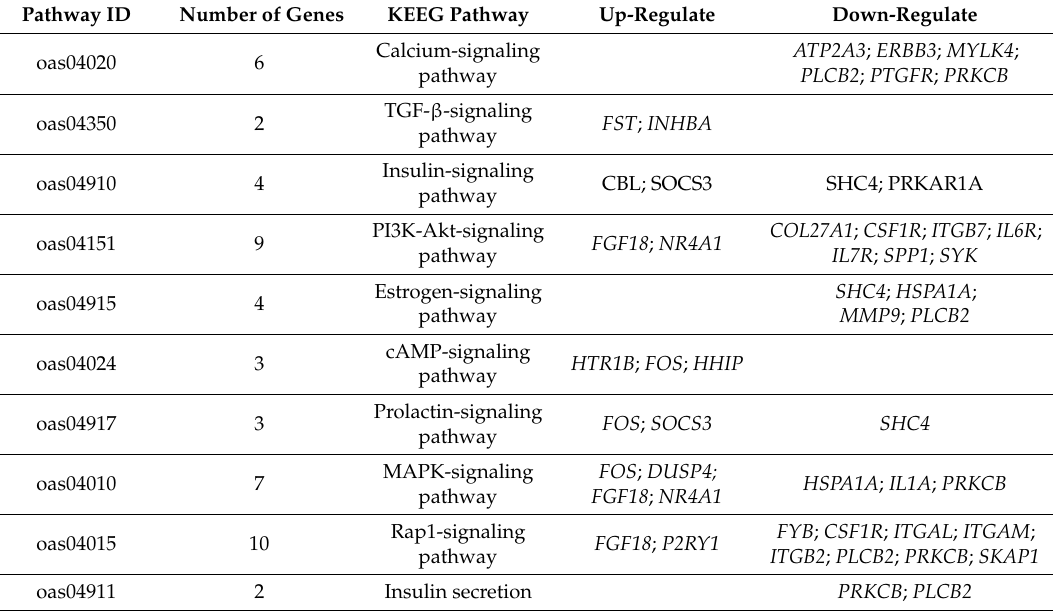
Table 4. The top 10 pathways of the DEG’s related to the reproductive processes in Pelibuey